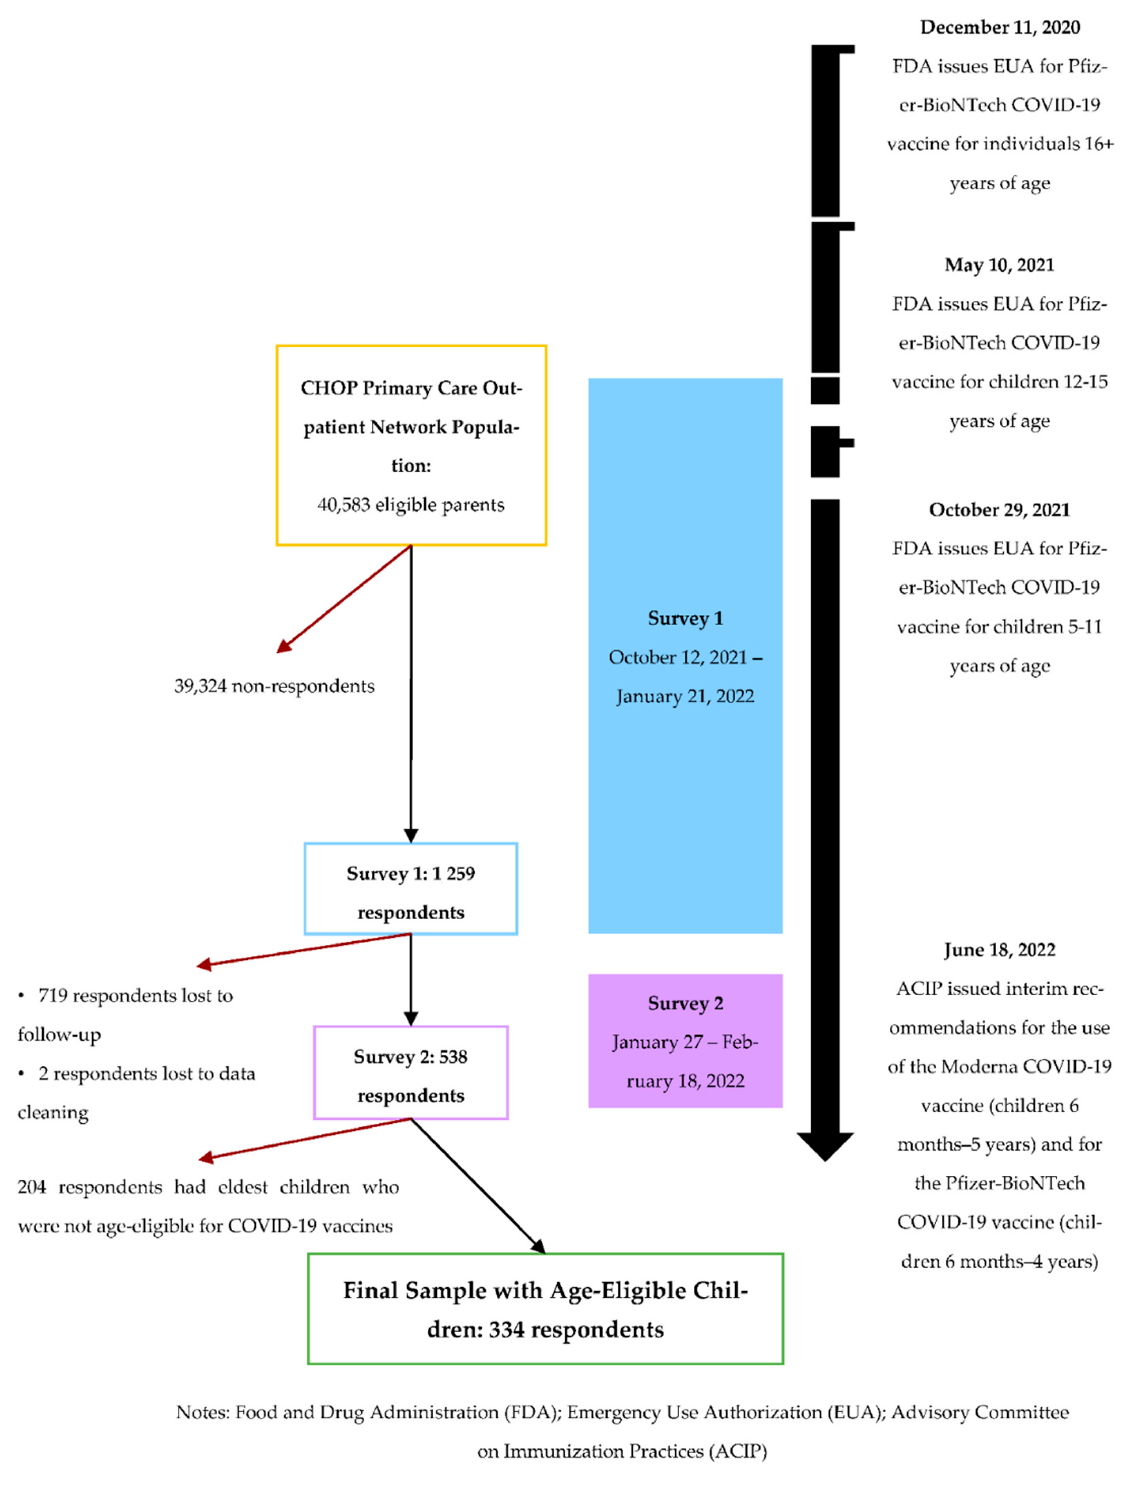
Figure 1. Study Recruitment for Longitudinal COVID-19 Vaccine Surveys from Children’s Hospital of Philadelphia (CHOP) Outpatient Primary Care Network, 2021–2022.